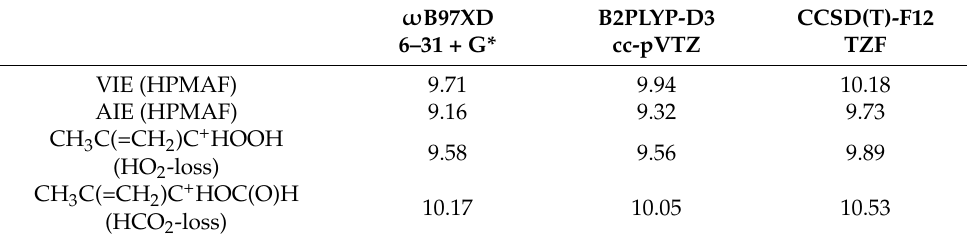
Table 1. Vertical ionization energy (VIE) and zero-point energy corrected adiabatic ionization energy (AIE) of HPMAF, and asymptotic energies for the anticipated fragment ions calculated at three levels of theory. All energies are reported relative to the most stable conformational form of HPMAF.